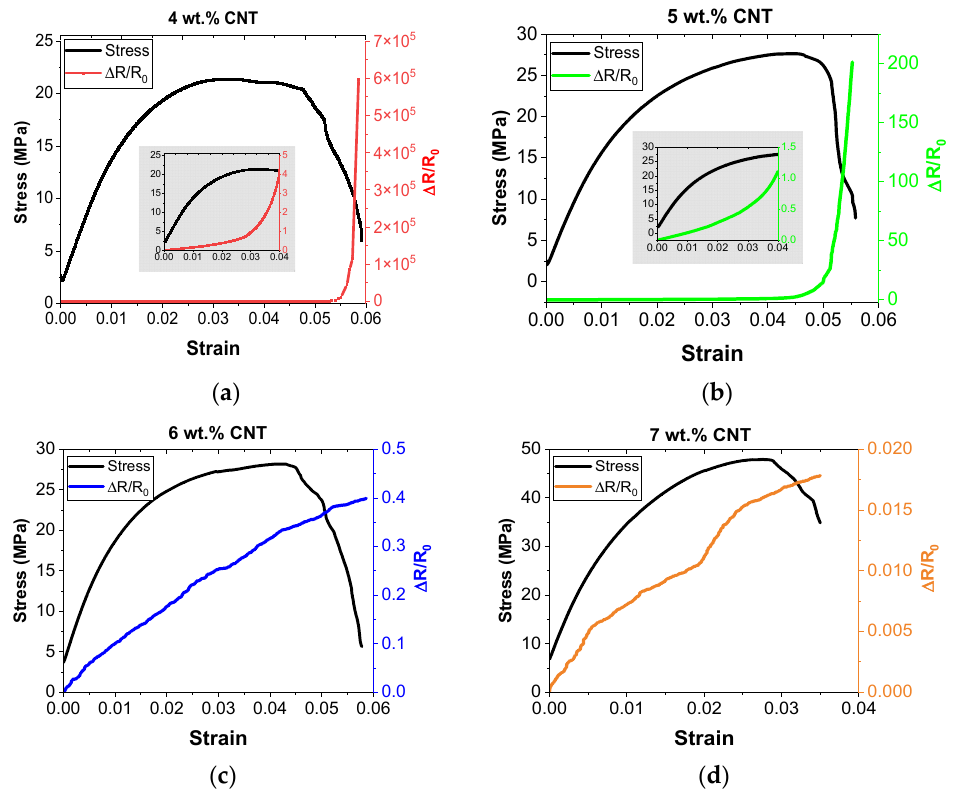
Figure 5. Electromechanical response of CNT–Surlyn nanocomposites under tensile conditions for ( a ) 4, ( b ) 5, ( c ) 6, and ( d ) 7 wt.% CNT.